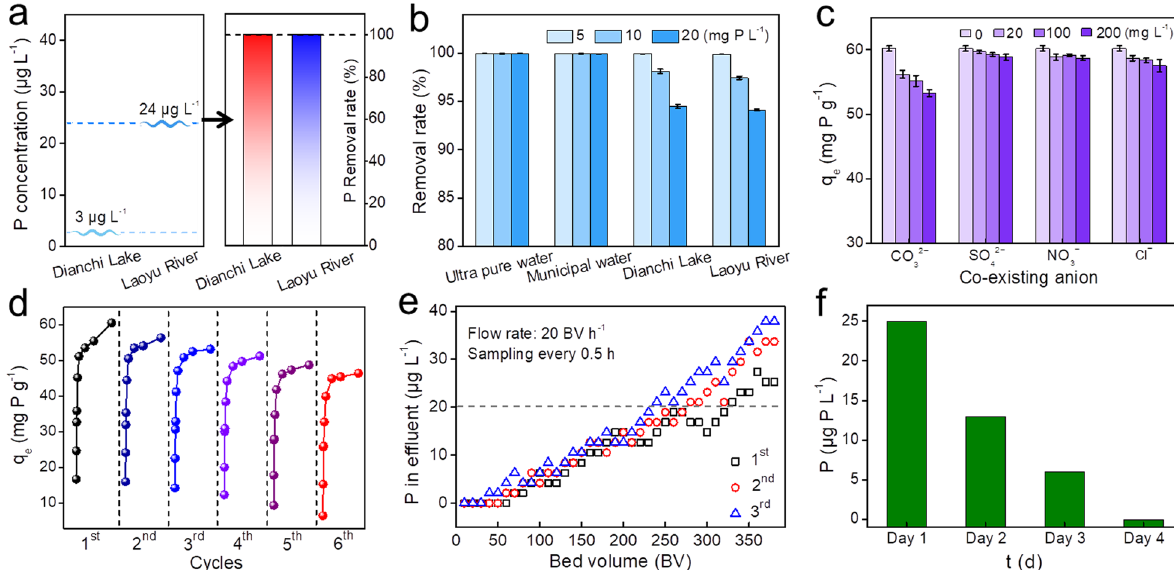
Fig. 5 a Adsorption of P by MSBL3 in natural water; b Adsorption of P in four water bodies by MSBL3 (Solutions of 5, 10, and 20 mg P L − 1